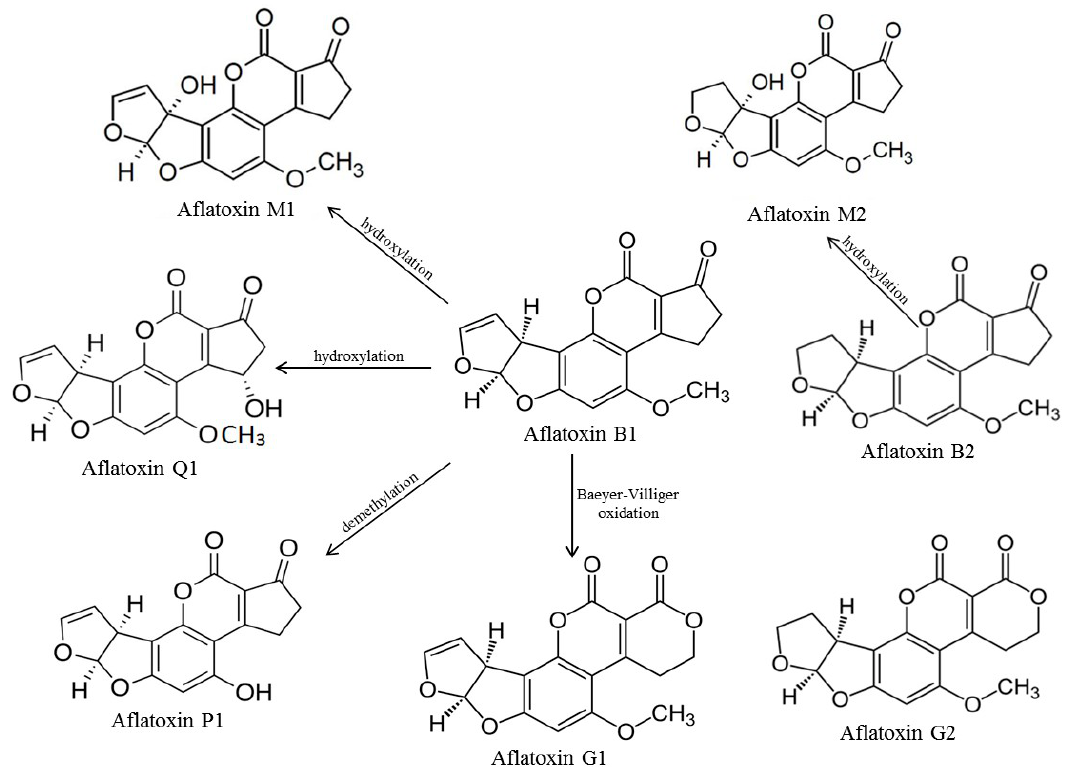
Figure 1. Chemical structures of aflatoxins and their metabolites.